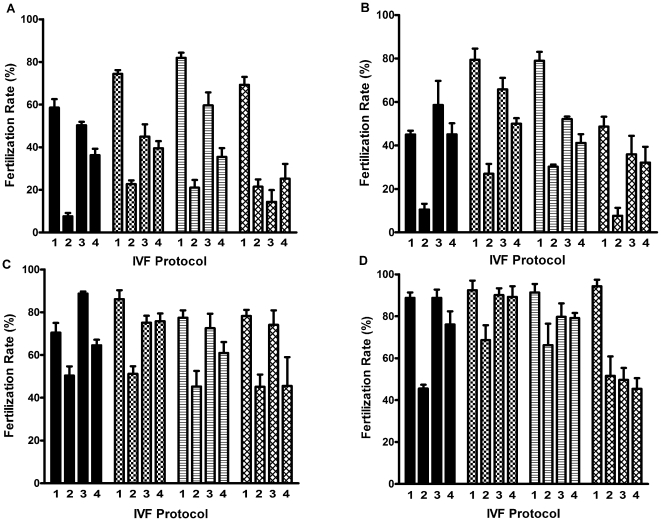
In vitro fertilization rates in medium containing reduced glutathione (GSH) and in medium lacking GSH.(A) C57BL/6J, (B) 129S1/svImJ, (C) FVB/NJ and (D) C3H/HeJ sperm, in fertilization medium containing reduced glutathione (GSH) and in medium lacking GSH. The bar patterns, in groups of 4, indicate the volume of cryoprotectant used to extend the sperm. From L to R: 105 µL, 180 µL, 400 uL and 800 µL. Numbers within each group of 4 bars indicate IVF Protocol: Protocol 1, 6.5 mm well + GSH; Protocol 2, 6.5 mm well − GSH; Protocol 3, 12 mm well + GSH; Protocol 4, 12 mm well − GSH. The fertilization medium was supplemented with 1.25 mM GSH for the C57BL/6J, 129S1, and FVB sperm and with 0.5 mM GSH for the C3H sperm. Data are presented as mean ± SEM, n = 4 and significance of differences is described in text.